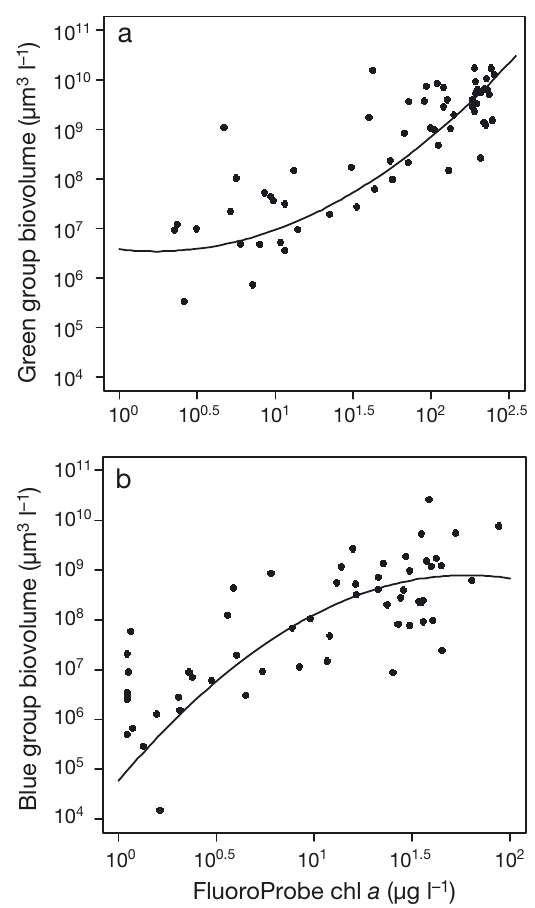
Fig. 3. Relationships between chlorophyll a (chl a ) measured by the FluoroProbe and respective biovolumes of (a) the green algal group (which includes chlorophytes and eugleno - phytes) and (b) the blue group (blue-green cyanobacteria). The fitted lines are regression